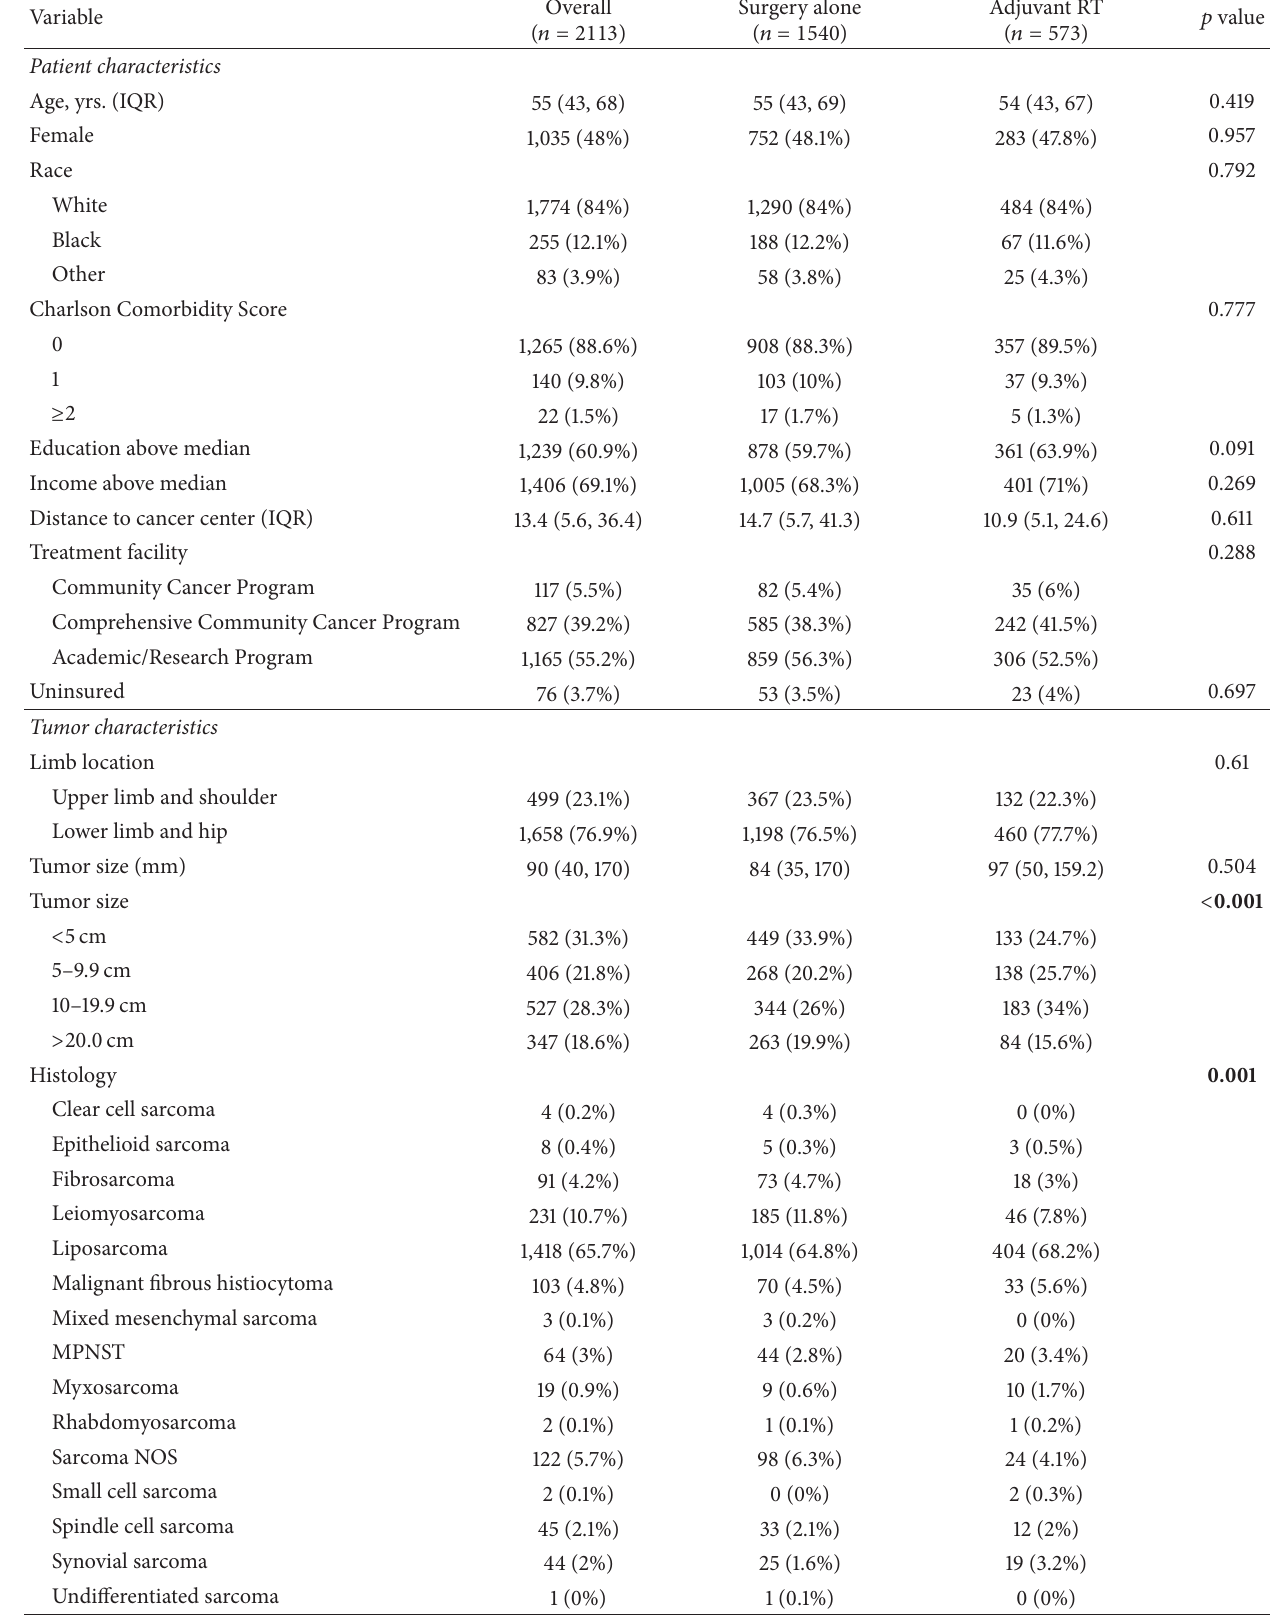
Table 1: Baseline characteristics for all patients with well-differentiated